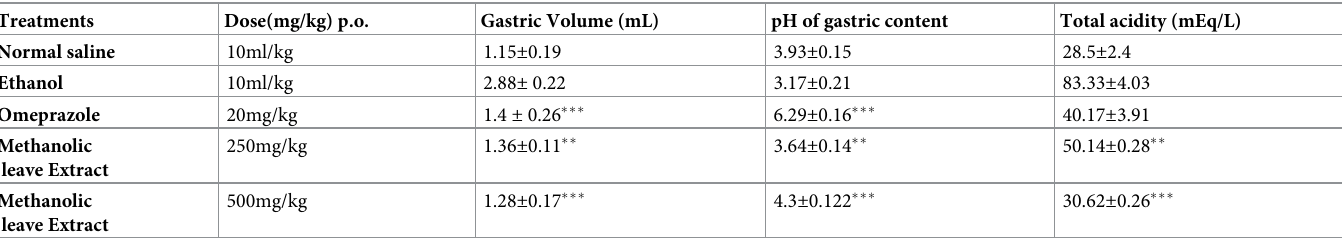
Table 9. Effect of different methanolic extracts E . spinosa on gastric ulcer, gastric Volume, pH, and total acidity in chronic aspirin-induced gastric ulcer. Treatments